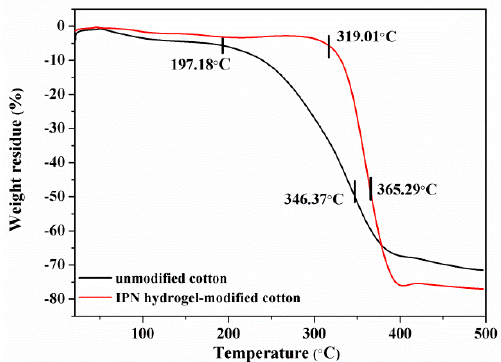
Figure 10. The TGA of cotton and m ss = 0.5 gL hydrogel modified cotton.